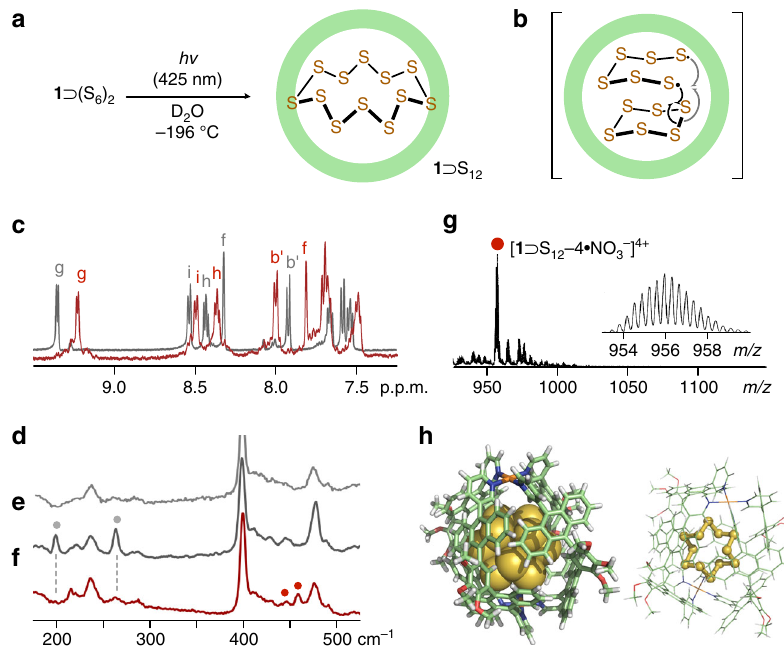
Fig. 4 Preparation and characterization of 1 ⊃ S 12 . a Schematic representation of the transformation from two S 6 clusters into a S 12 cluster within matrix 1 upon light irradiation and b the proposed intermediate. c 1 H NMR spectra (500 MHz, D 2 O, room temperature) of 1 ⊃ S 12 ( red line ) and 1 ⊃ (S 6 ) 2 ( gray line ). Raman spectra (He − Ne laser, λ ex = 632.8 nm, room temperature) of d 1 , e 1 ⊃ (S 6 ) 2 , and f 1 ⊃ S 12 . g ESI-TOF MS spectrum (H 2 O) of 1 ⊃ S 12 . h Optimized structure of 1 ʹ ⊃ S 12 (R = − OCH 3 ): cylindrical and space- fi lling representation ( left ) and ball-and-stick representation ( right